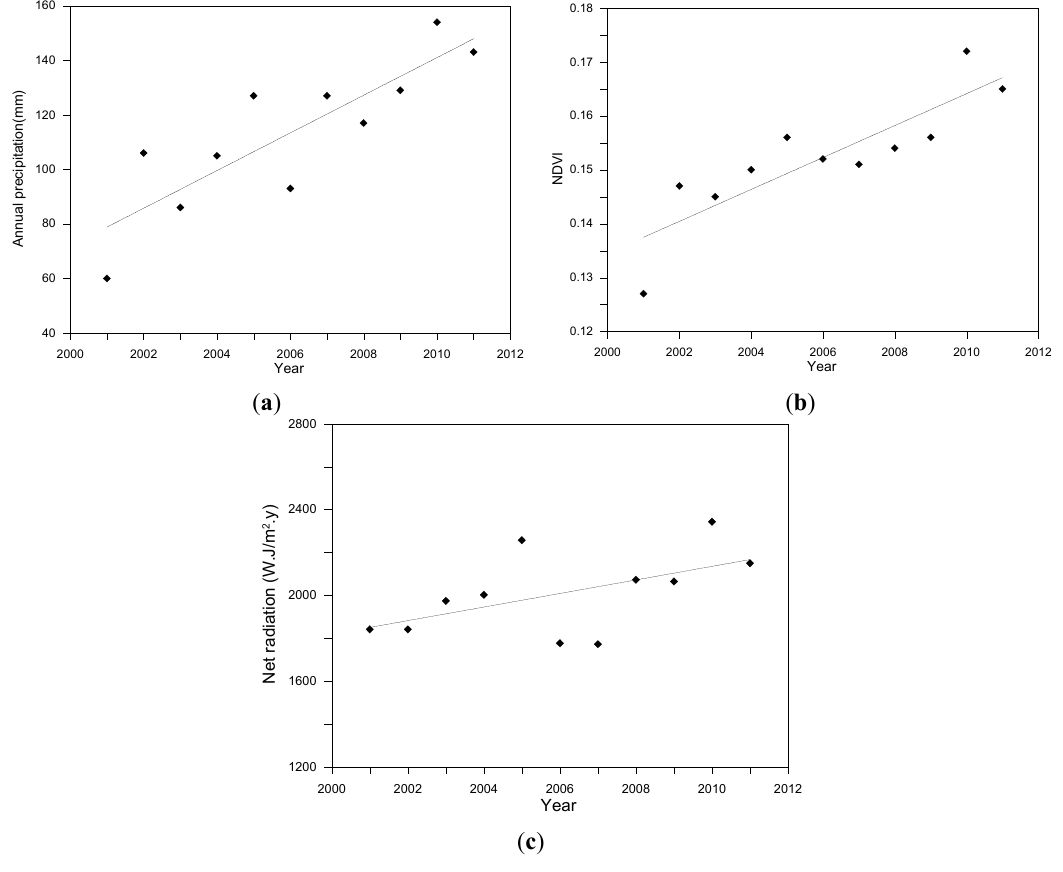
Figure 6. Variation of ( a ) annual precipitation, ( b ) NDVI and ( c ) net radiation during the period of 2001–2011 in Qaidam